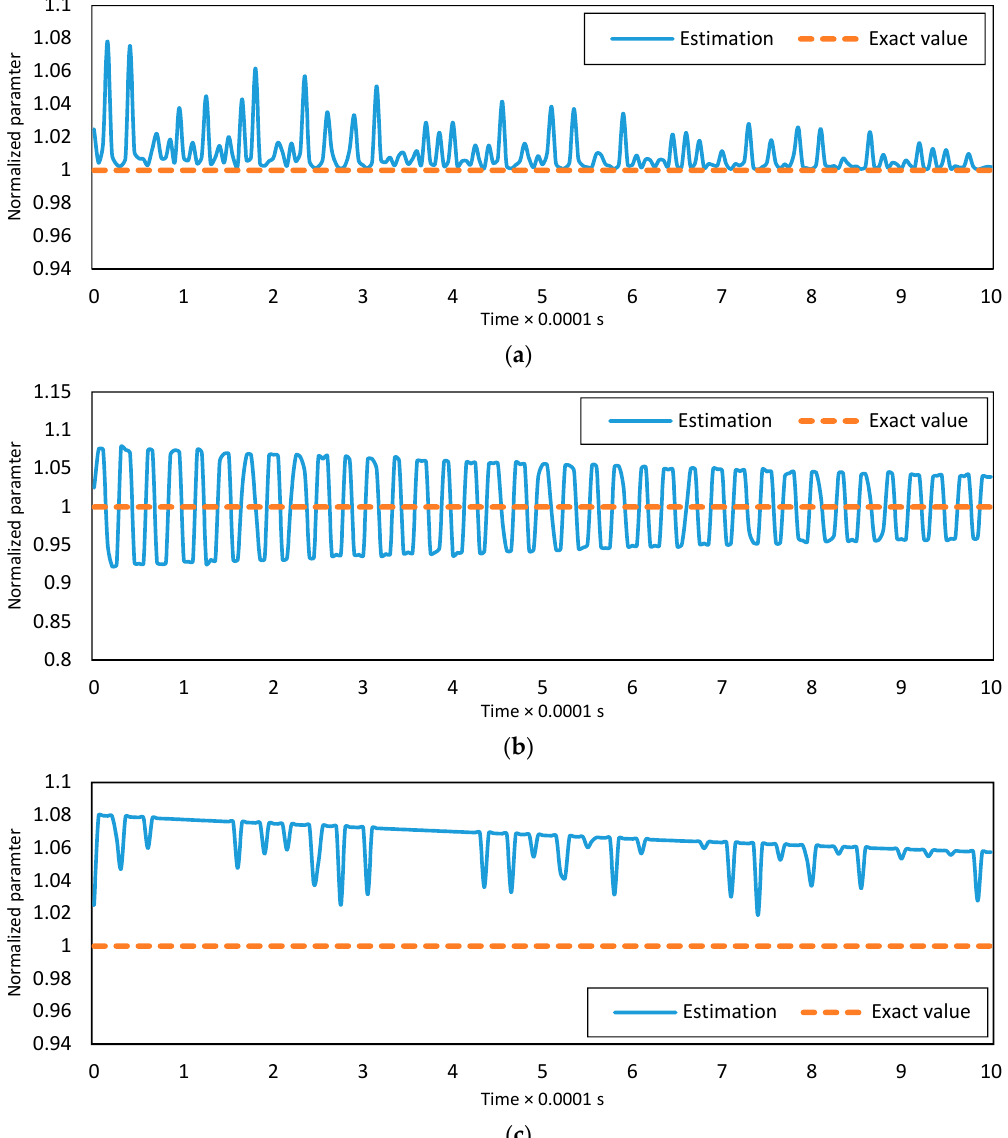
Figure 6. Estimation of the parameters; ( a ) α 1 , ( b ) α 2 , and ( c ) α 3